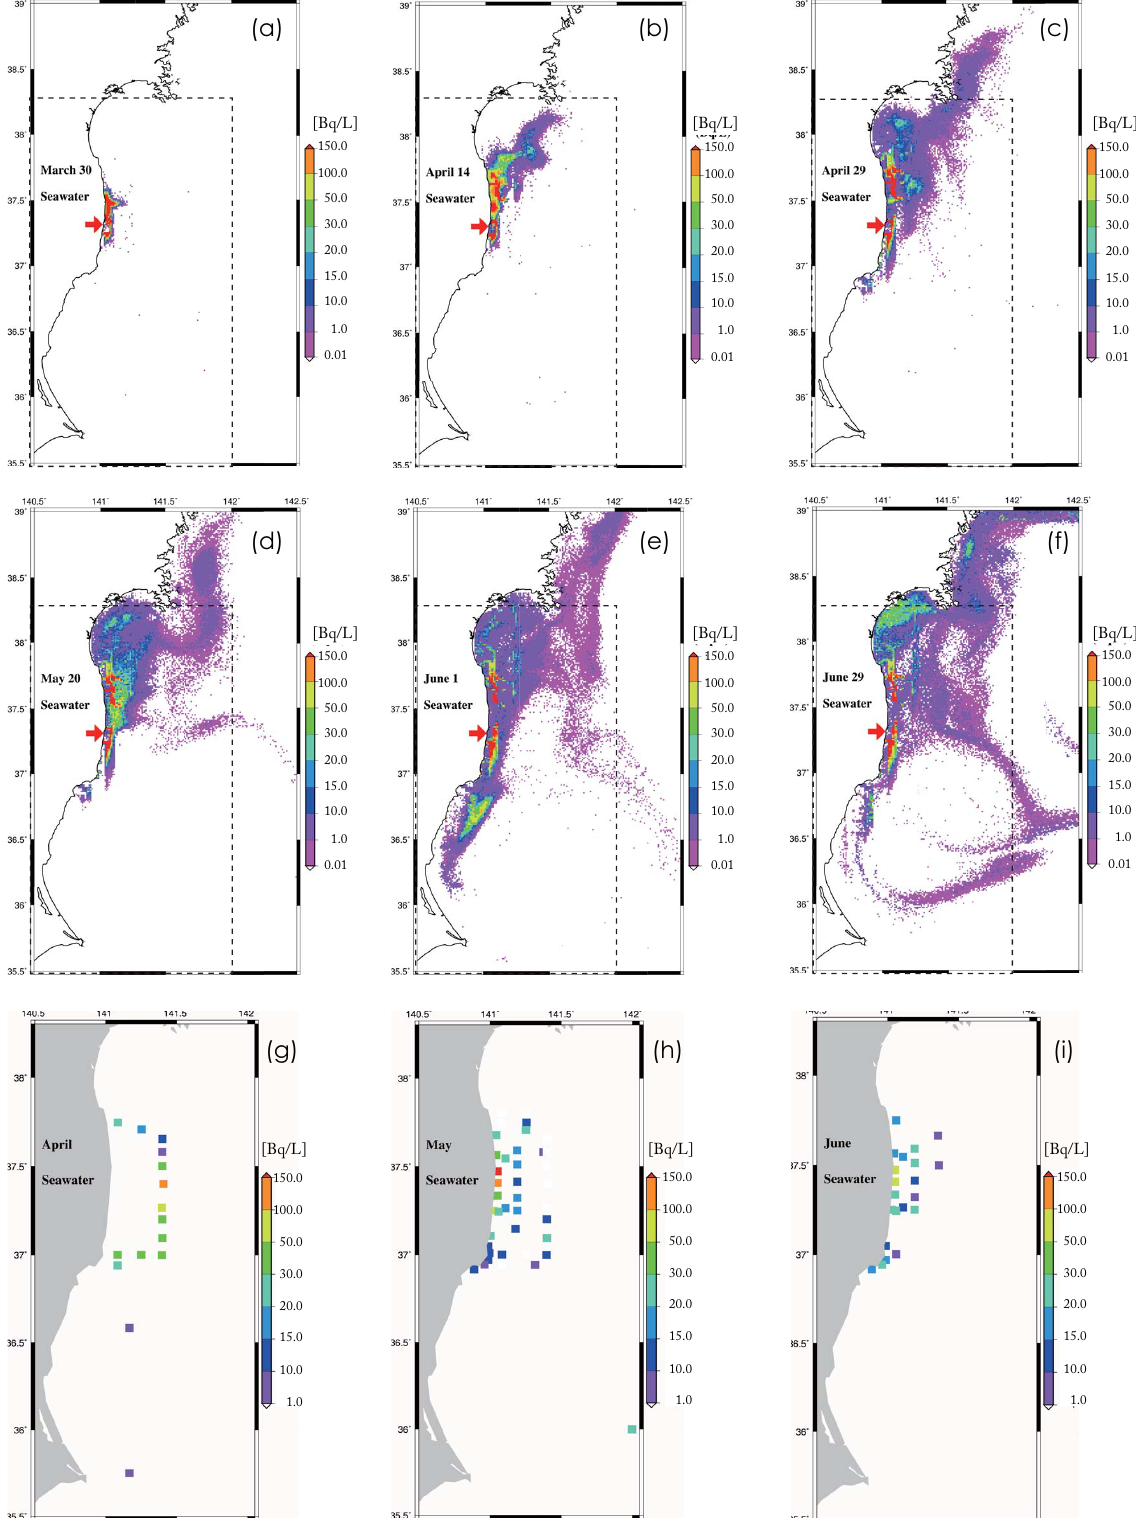
Fig. 6. (a–f) Radionuclide concentrations in seawater (dissolved and LPM phases) collected between 0–150m in CTRL: (a) 30 March, (b) 14 April, (c) 29 April, (d) 20 May, (e) 1 June, and (f) 29 June 2011. (g–i) Monthly averages of observed radionuclide concentration in seawater: (g) April, (h) May, and (i) June